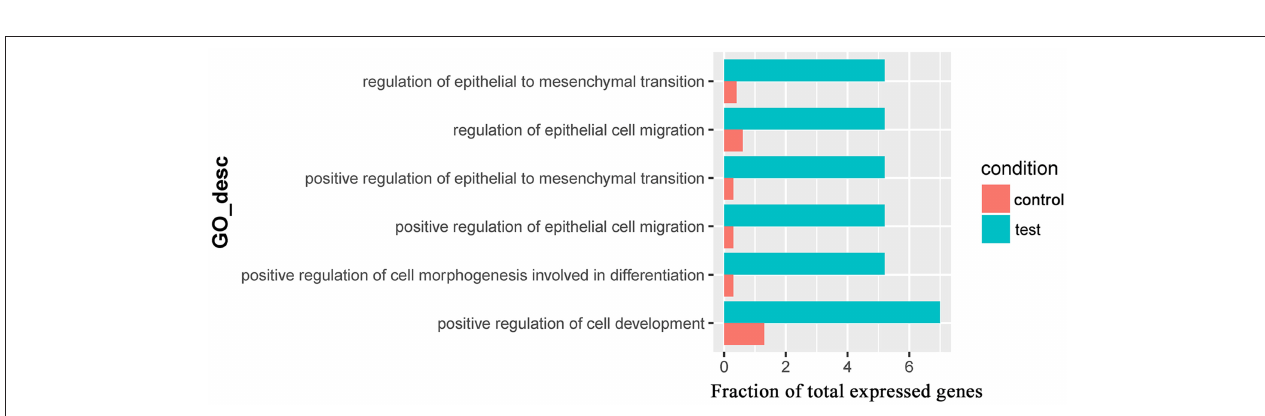
FIGURE 5 | The overrepresented GO terms of the common significantly upregulated genes in the Control_10h/Heat_10h and Control_18h/Heat_18h comparisons in coral Galaxea fascicularis .